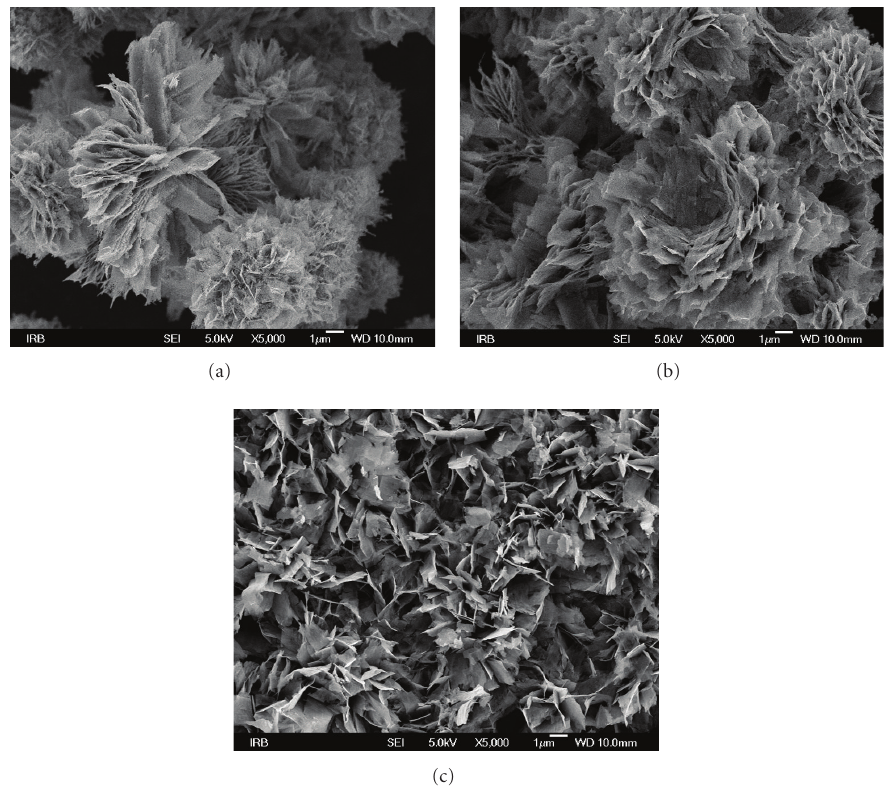
Figure 2: FE-SEM pictures of sample A (a), sample B (b), and sample C